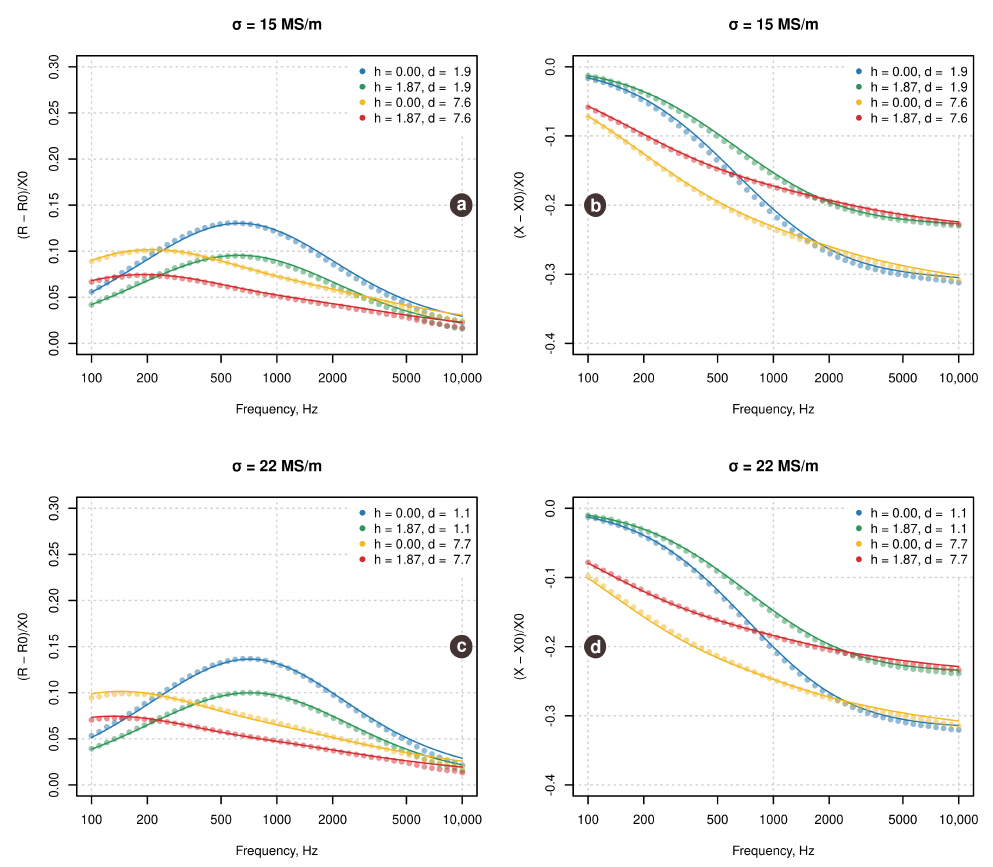
Figure 3. Relative resistance ( left ) and reactance ( right ) for the two alloys and selected combination of thickness and lift-off. Points show experimental data, measured using the EC-sensor. Curves show theoretical signals computed using model described in Section